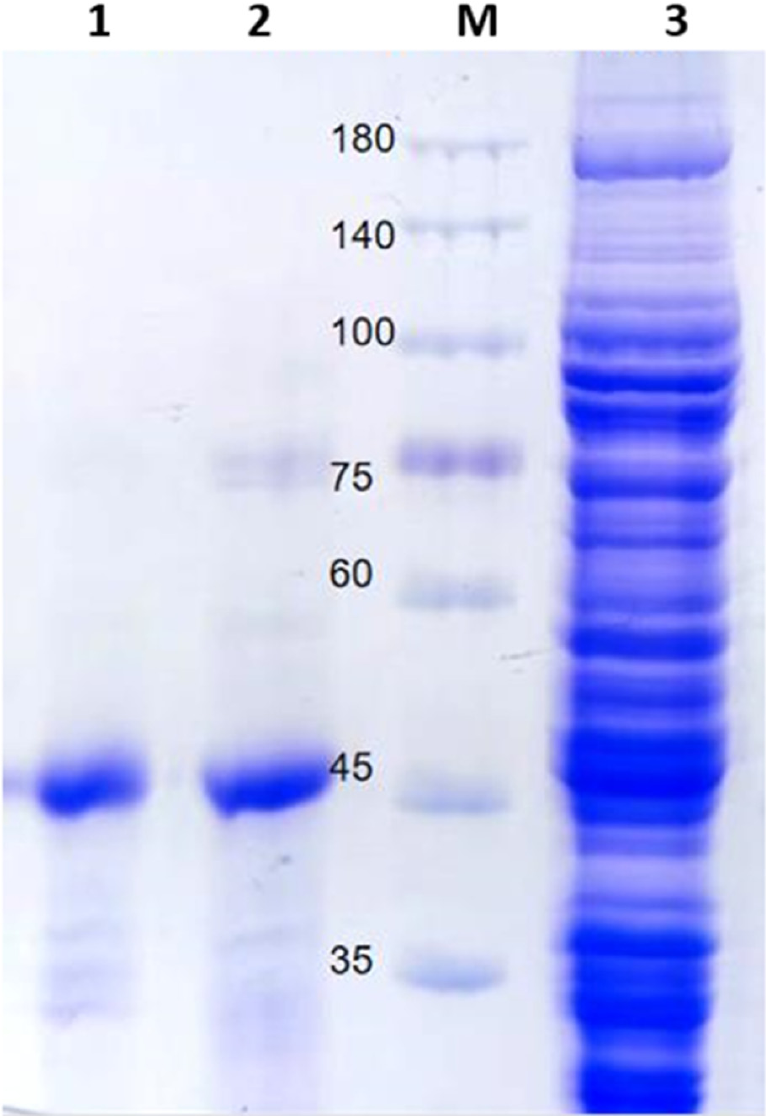
Figure 4. Sodium dodecyl sulfate–polyacrylamide gel electrophoresis analyses of recombinant EsFBA on a 10% gel. M: marker; Lane 1: protein purified from 500 mM imidazole; Lane 2: protein purified from 500 mM imidazole; Lane 3: supernatant.